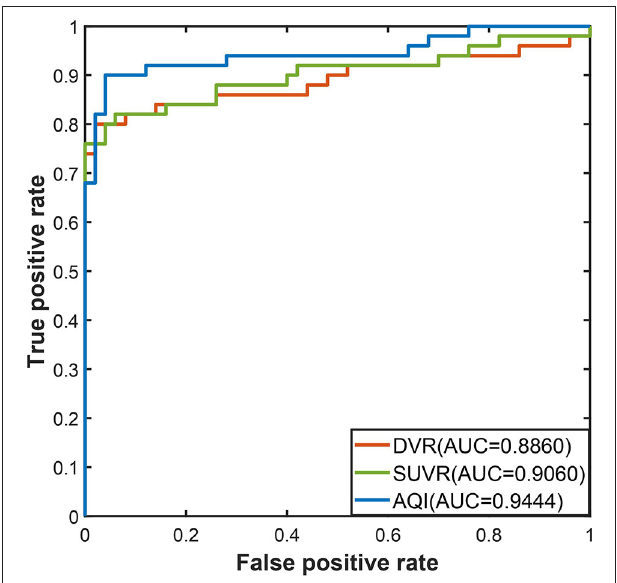
FIGURE 4 | ROC curves for three methods in the training set.